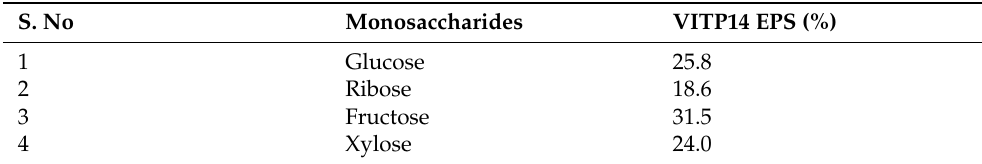
Table 2. Monosaccharide composition of exopolysaccharides (EPSs).